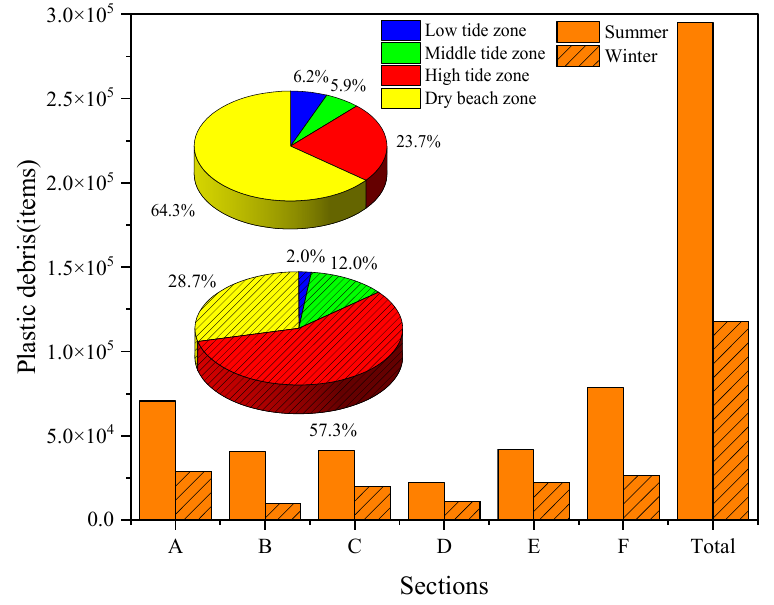
Figure 7. The inventory of plastic debris on the Yugang Park Beach.